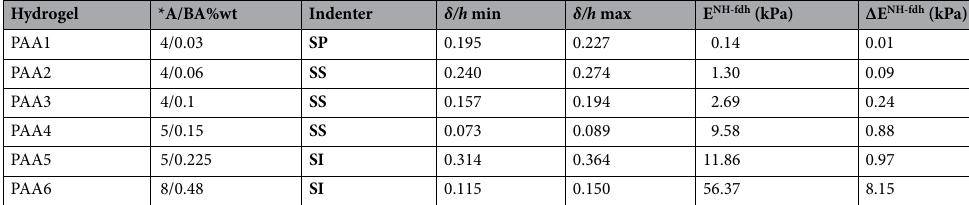
Hydrogel *A/BA%wt